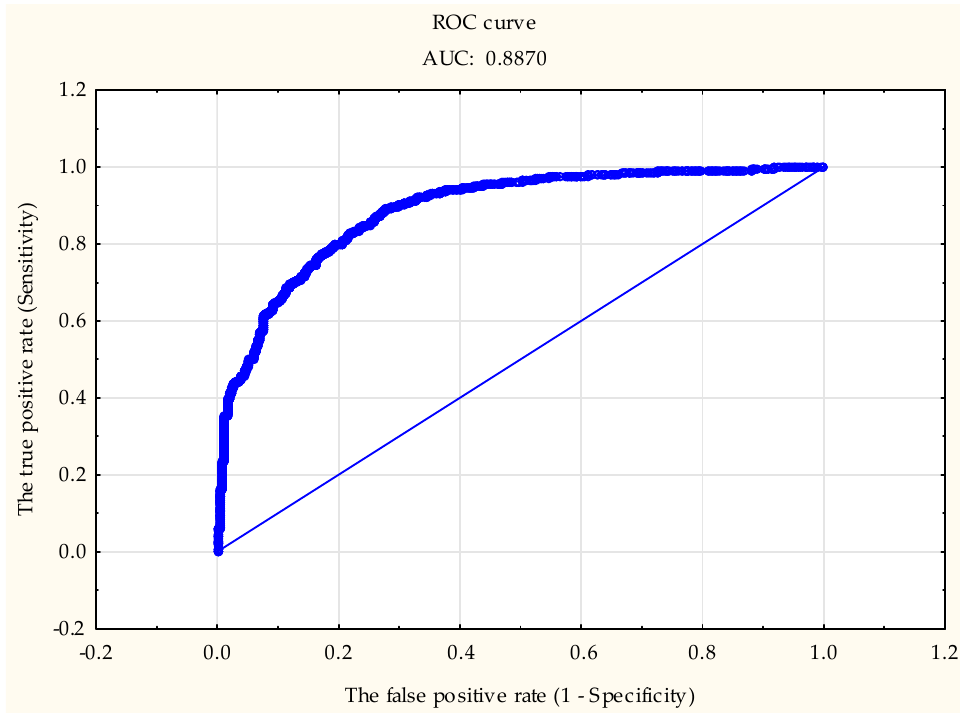
Figure 2. ROC curve for the Polish Industry—eco-innovation equation. Source: own calculation with Statistica software support based on questionnaire research.